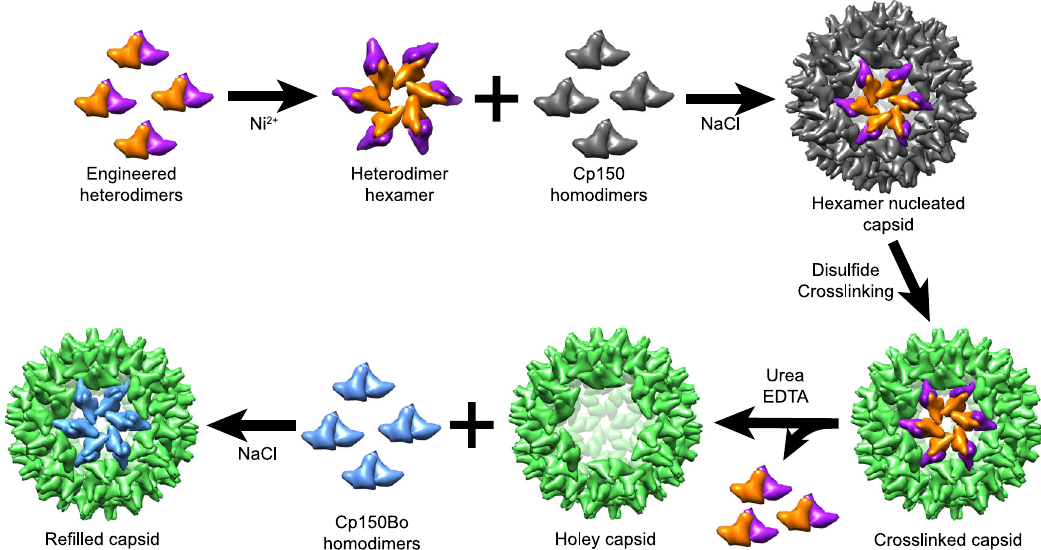
Fig. 1 Schematic of the hierarchical assembly of an HBV capsid analog starting with an asymmetric dimeric subunit. Engineered HBV heterodimers (orange and purple) assemble into hexamers by addition of Ni 2 + . The hexamer model in this fi gure provides a proposed representation of the interaction between dimers. Hexamers nucleate co-assembly with Cp150 homodimers (gray) into capsids. After crosslinking the Cp150 surface (now green), co- assembled capsids are disassembled into holey capsids by removing the patch corresponding to the nucleating hexamer. Holey capsids then can be surface-re fi lled into compete capsids with the addition of a new species of homodimer (blue). It is noteworthy that the co-assembled capsid and re fi lled capsid have a de fi ned patch, allowing display of a unique surface chemistry. Also, the opening in the holey capsid offers the opportunity to add a cargo to the